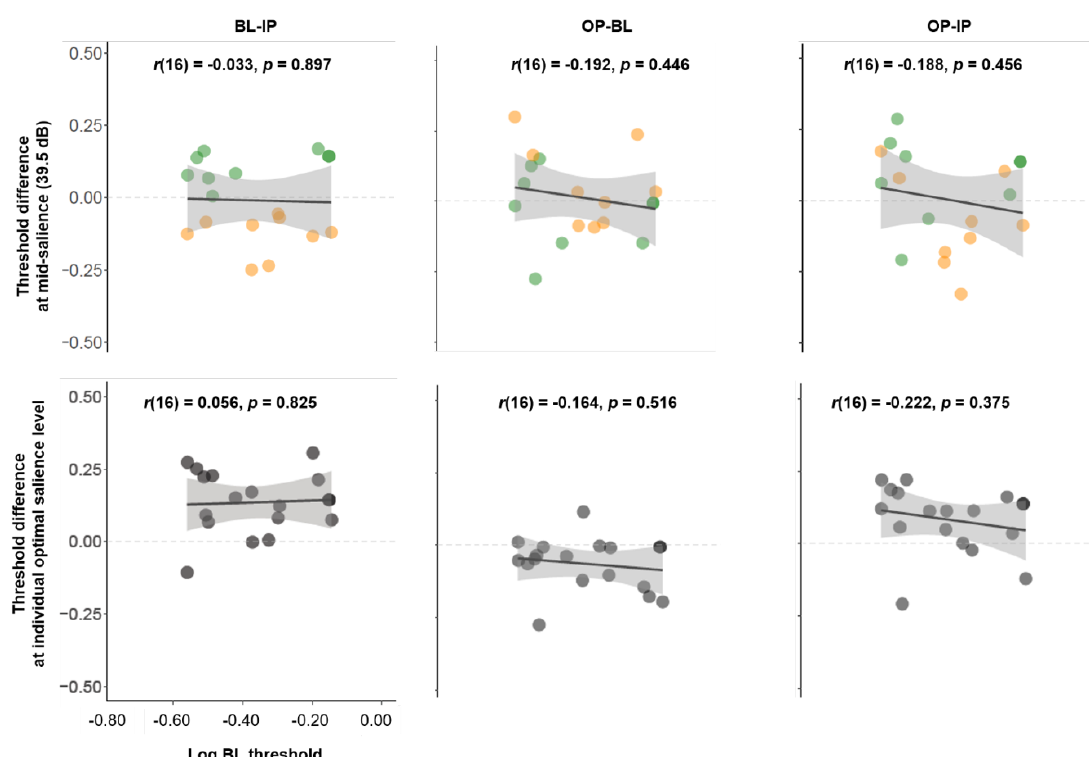
Figure 7. Correlation of log BL threshold against threshold differences (BL-IP, OP-BL, and OP-IP) at mid-salience levels (39.5 dB, top panel) and at optimal salience levels (bottom panel).